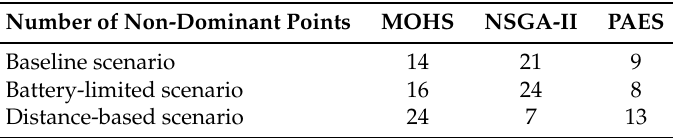
Table 1. Number of Non-dominant points in the resulting Pareto Front per multi-objective approach and real use case scenario.